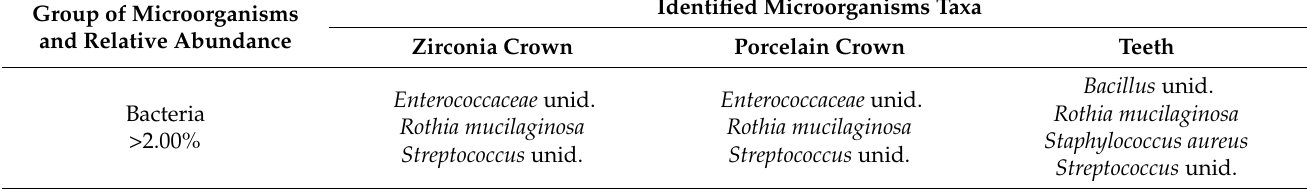
Table 3. The identification results of microorganisms isolated from the surfaces of teeth zirconia crowns and porcelain crowns using the NGS